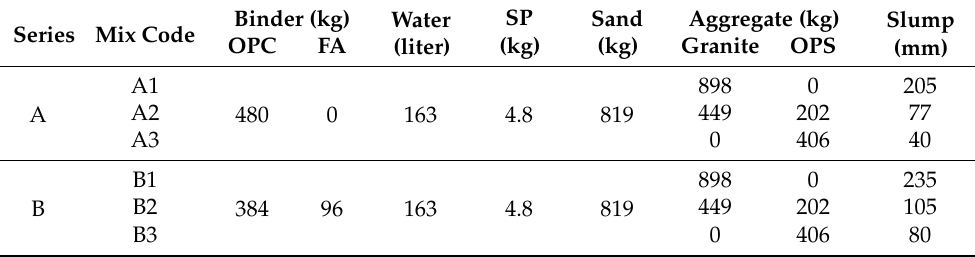
Table 4. Concrete mix